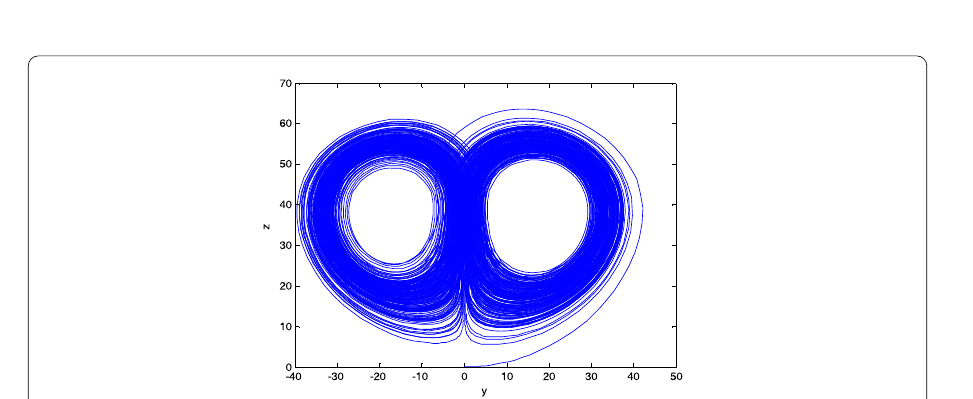
Figure 2 Chaotic attractors of system (2) in yOz plane.